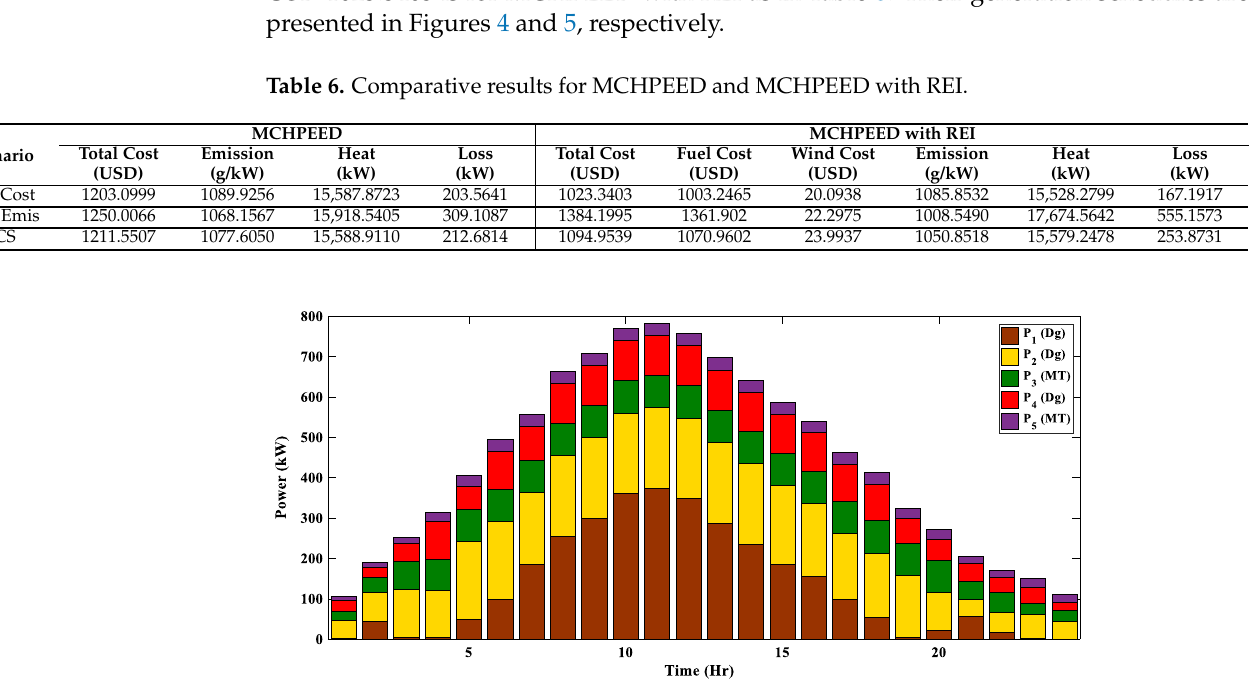
Figure 4. The generation scheduling of MSCHPEED for cost minimization.